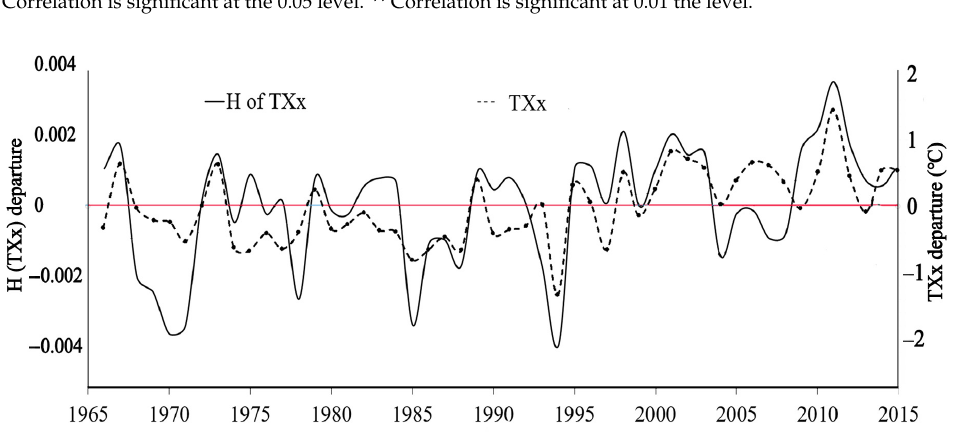
Figure 14. Theoretical changes in the distribution of climate variable values. 4.2. Effects of Atmospheric Circulation on Extreme Temperature Instabilities Previous studies have identified important effects of atmospheric circulation on the occurrence of extreme climate events [41,42], and this section will discuss whether atmos- pheric circulation has an impact on the instability of extreme temperatures. Table 3 and Figure 15 shows a positive correlation between H(TXx) and El Niño T, while H(CTXx) is significantly correlated with PDO. Overall, the correlation between ENSO and H(TXx) is the most pronounced, with a correlation coefficient of 0.39.